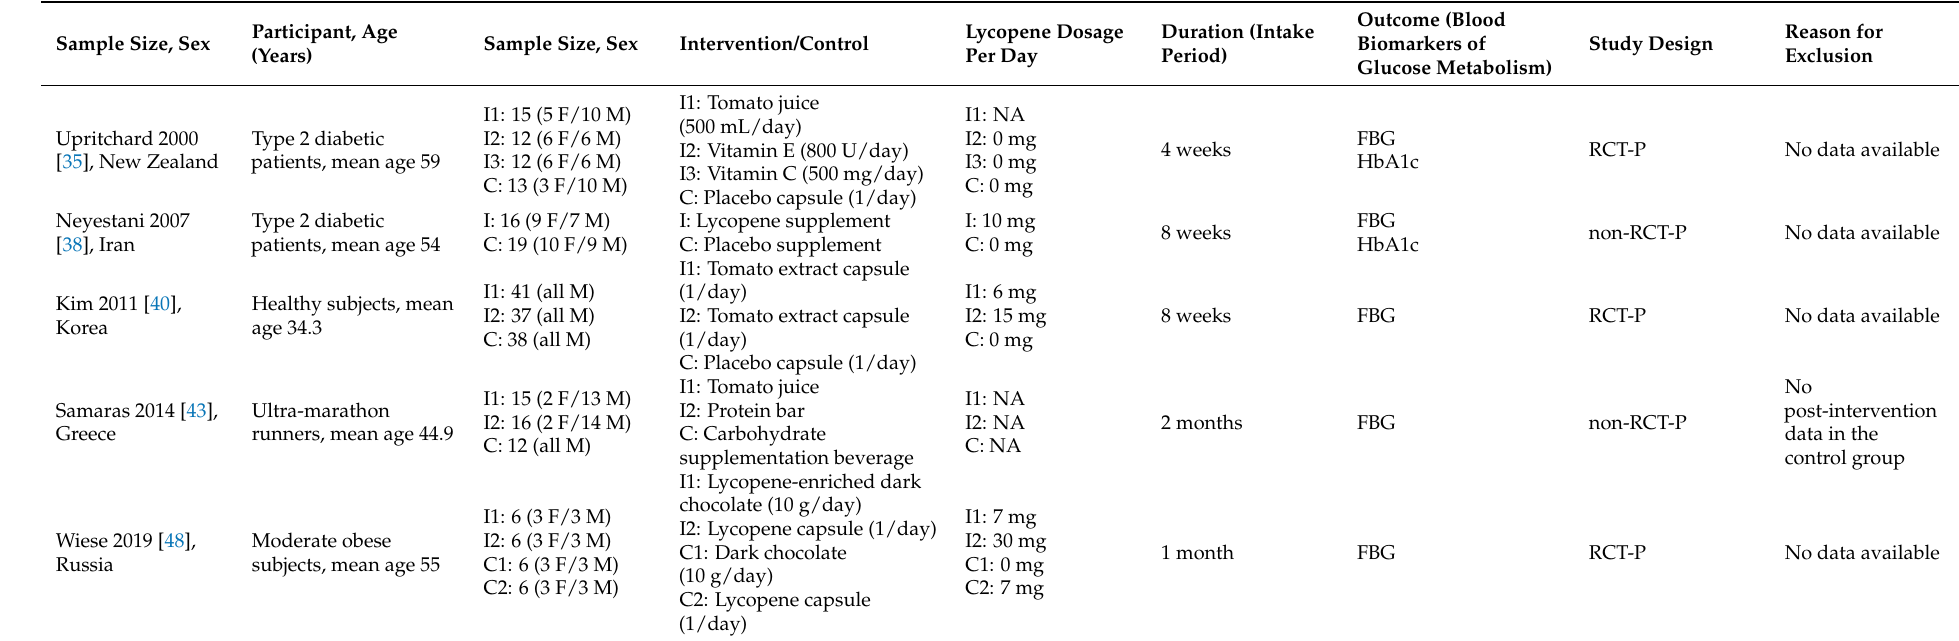
Table 3. Characteristics of the excluded